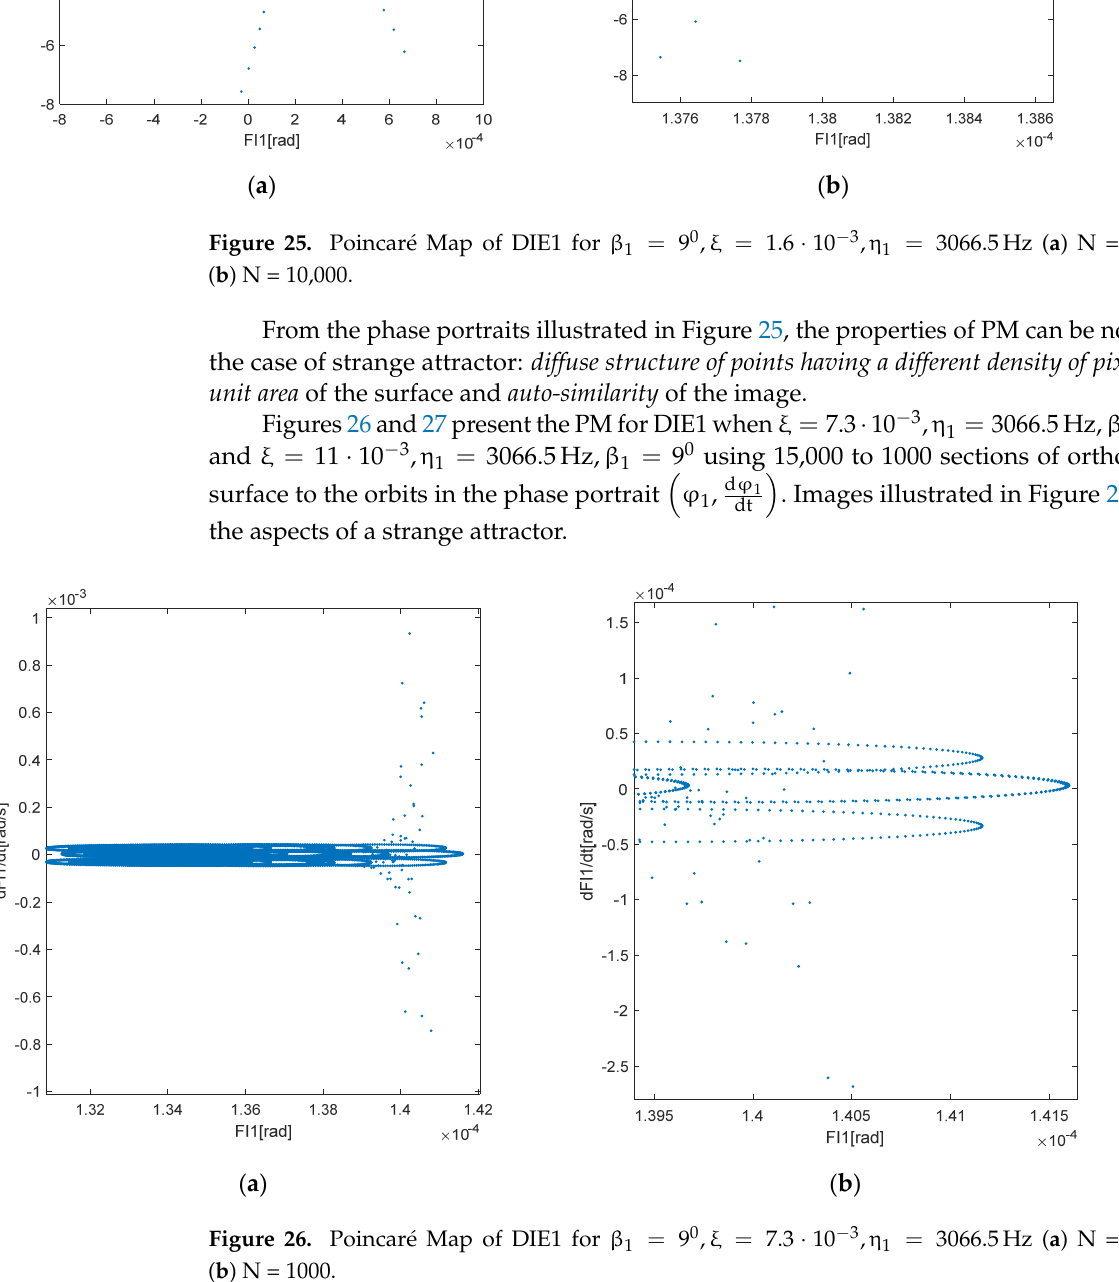
( b ) Figure 27. Poincaré Map of DIE1 for ( a ) N = 10,000 ( b ) N = 1000. The aspect of the image in Figure 26 has a chaotic manifestation specific to determin- istic chaos (strange attractor), and the aspect of the images of both Figures 26 and 27 are like those presented in Figure 25. Comparing the images presented in Figure 26 with those illustrated in Figure 27, it can be concluded that the strange attractor started to vanish because we were close to the condition